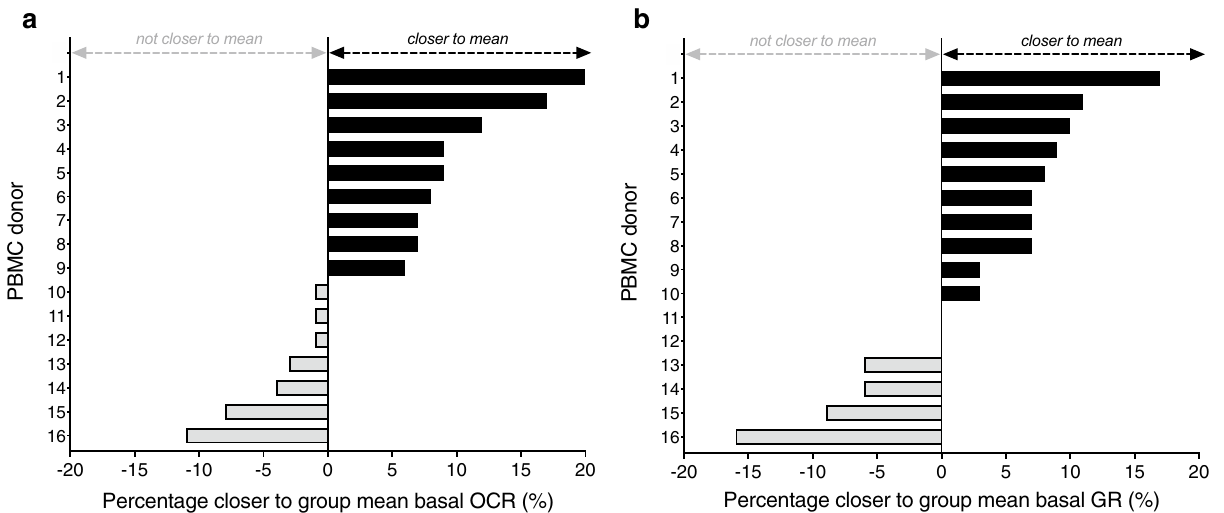
Figure 6. Effects of PIXI analysis on the variation between PBMC donors. ( a , b ) The percentage (%) by which individual donor basal OCR ( a ) and basal GR ( b ) levels moved closer to the group mean after PIXI